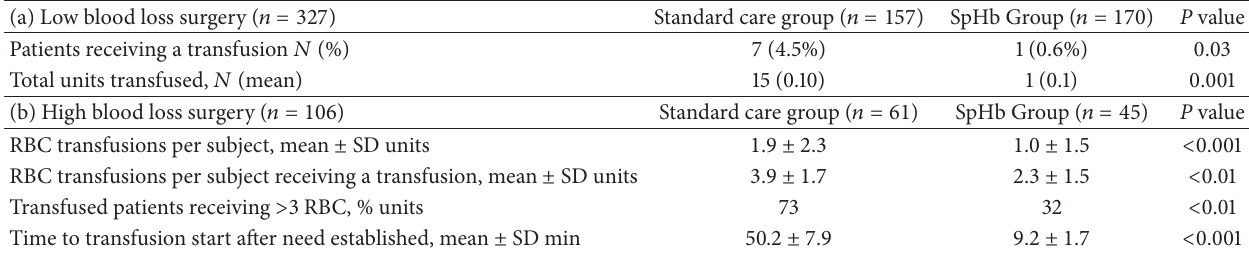
Table 1: Differences in red blood cell transfusions when clinicians used standard of care blood management or added SpHb monitoring to guide transfusions in (a) 327 surgery patients with expected low blood loss and (b) 106 surgery patients with expected high blood loss.